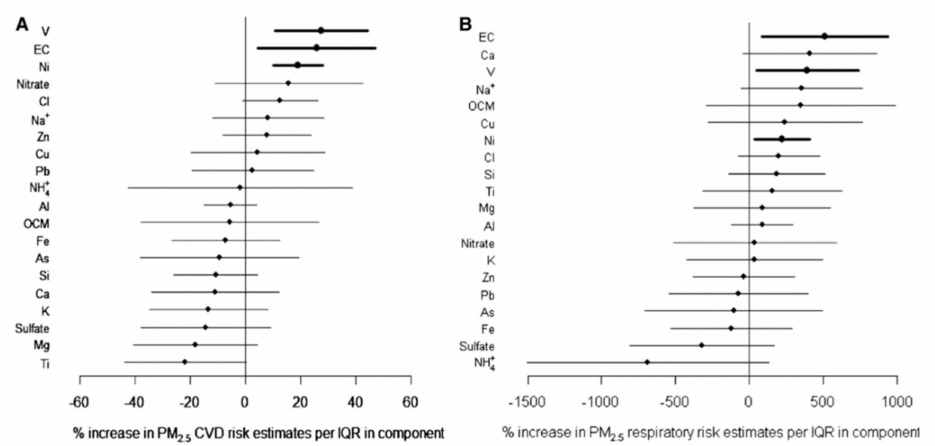
Figure 2. PM 2.5 component hospital admissions risk coefficients shown as the 5th–95th percentile difference in concentrations of PM 2.5 constituents for US metropolitan areas (from [98]), where: ( A ) shows the risk of cardiovascular (CVD) hospitalization per constituent exposure interquartile range (IQR); ( B ) shows the risk of respiratory hospitalization per constituent exposure IQR. (OCM = Organic Carbonaceous